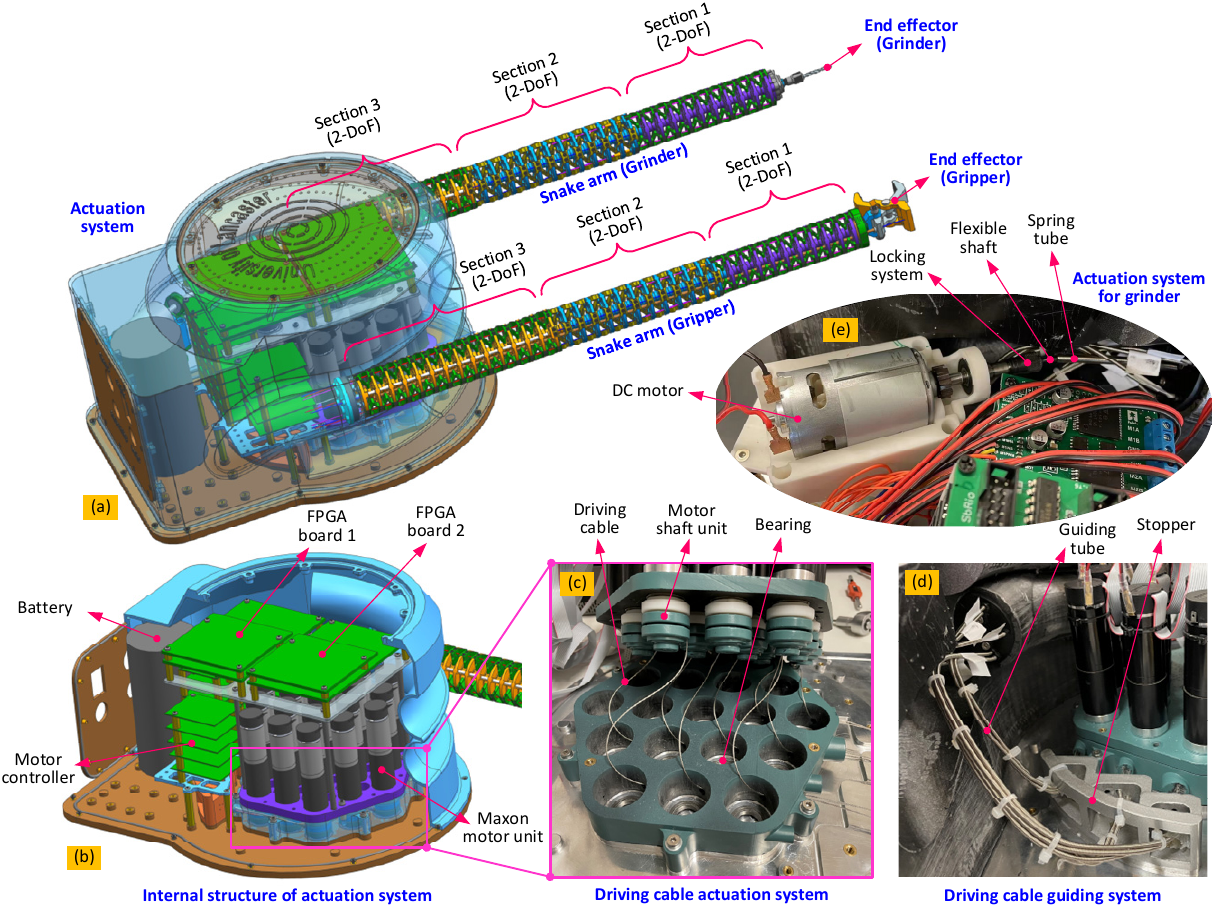
Figure 1. Detailed structural schematic of the dual-arm continuum robot: ( a ) is the overall structure of the continuum robot with the extended dual continuum arms, ( b ) is the internal structure of the actuation pack, ( c ) is the actuation principle for the continuum arms [8,26,27], ( d ) is the cable guiding system for controlling the continuum arm and gripper, ( e ) is the actuation system for the grinder. Each biomimetic snake arm is composed of three 2-DoF sections, each providing 6-DoF for each arm. This allows for the control of the position and orientation of the